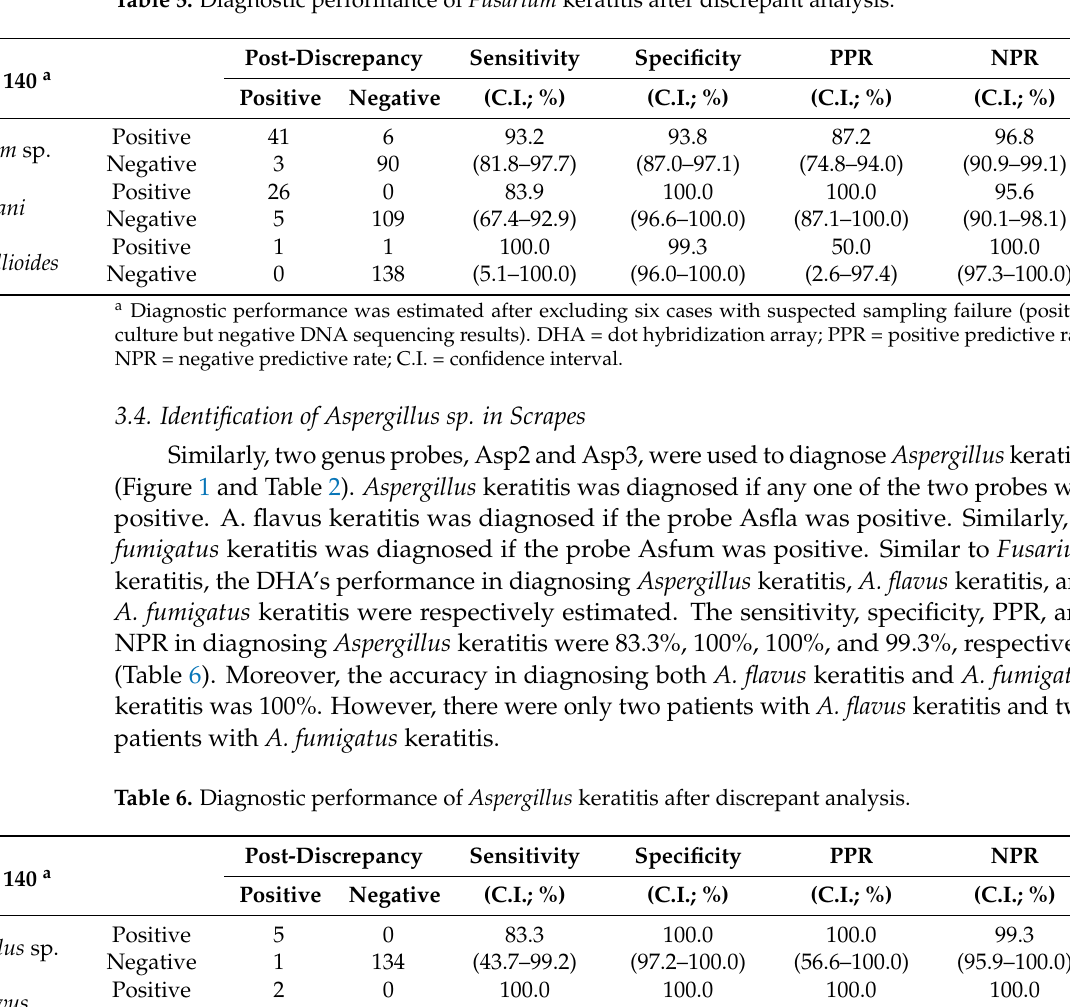
Table 5. Diagnostic performance of Fusarium keratitis after discrepant analysis.